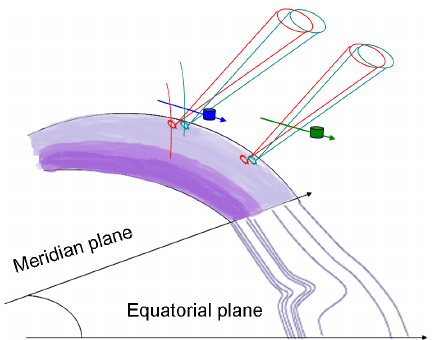
Figure 10. Sketch of NTC beams in 3-D, carrying each a specific spectral signature df , illustrating how beams of similar cone angle might be crossed one at a time near sources (case of C4, in blue) and at the same time at larger distances (case of C3, in